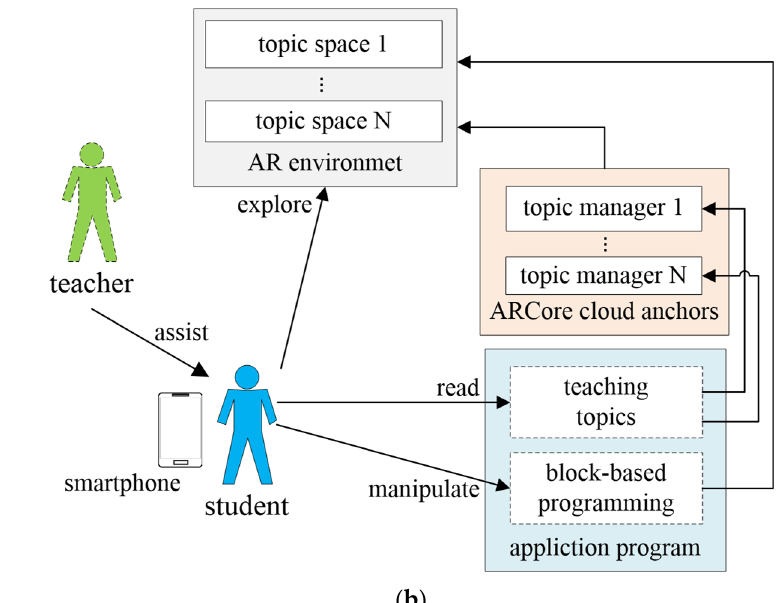
Figure 1. Comparison between ( a ) the traditional logic programming teaching method and ( b ) the proposed AR-based logic programming teaching method. In traditional logic programming teaching, teachers mainly teach concepts and describe problems through lectures, while students solve and verify problems through program coding. In the proposed AR-based logic programming teaching, students play a crucial and active role in operating the teaching system, and teachers serve the role of learning facilitators in teaching.